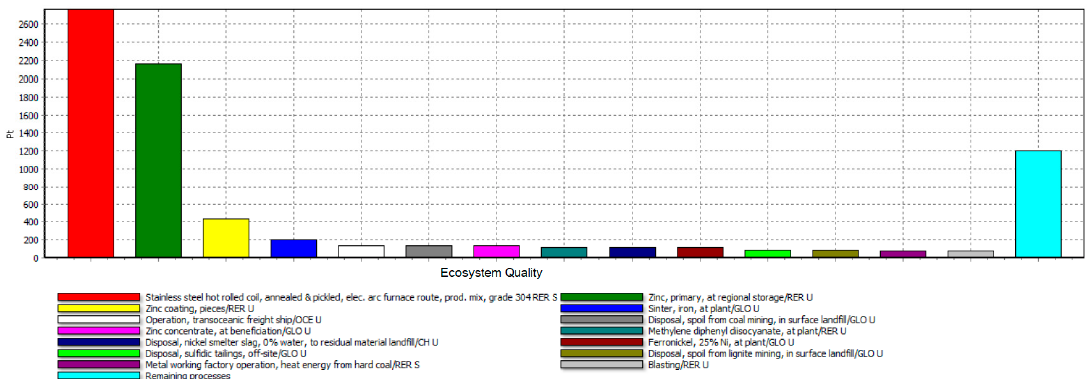
Figure 7. Comparison of major environmental impacts, related to the steel structure of the o ffi ce building, on the ecosystem quality damage